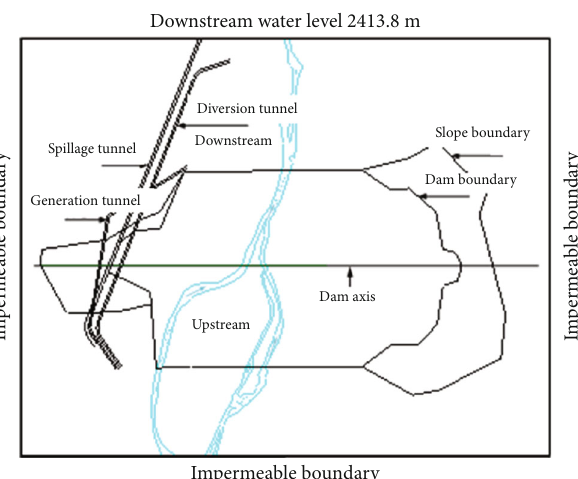
Figure 4: Top view of fi nite element model.